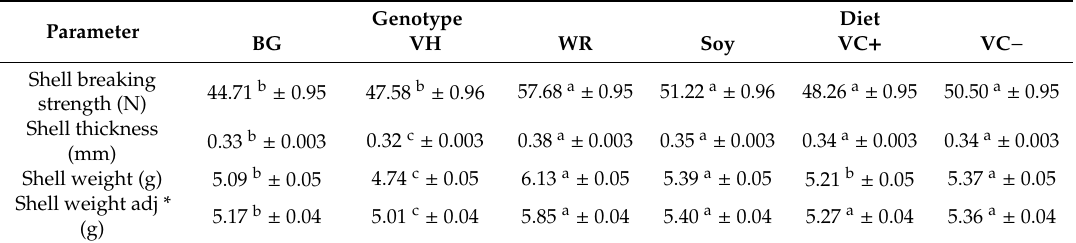
Table 3. LS-means ± SE for eggshell breaking strength, shell thickness and shell weight in purebreds (experiment A).